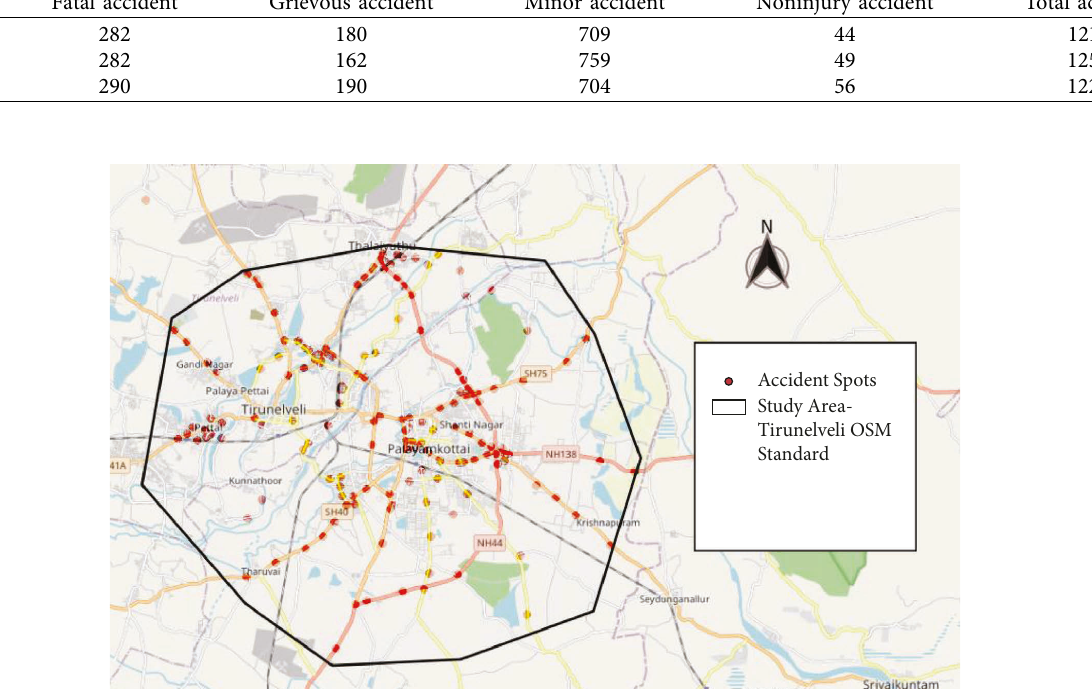
Figure 2: Map showing geo-referenced accident data (fatal, grievous, minor, and noninjury accidents, Tirunelveli city).